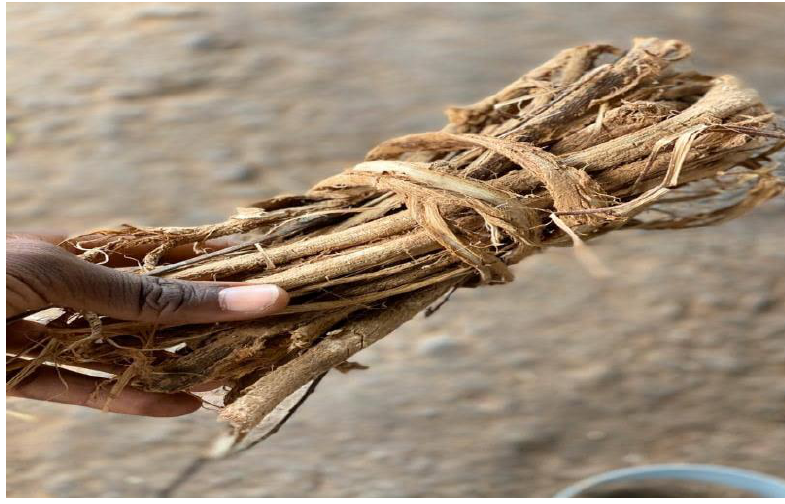
Figure 4. A typical Ghanaian ‘yolga’ used in brewing pito.